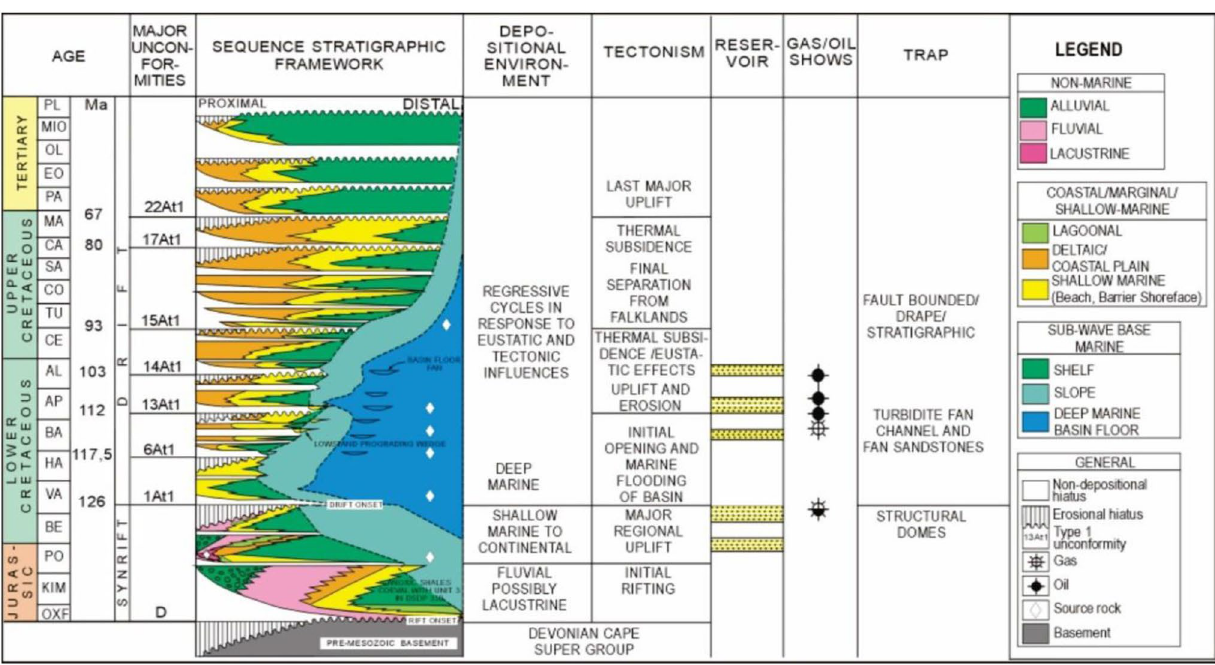
Fig. 2 Chronostratigraphy of Bredasdorp Basin (Petroleum Agency South Africa,